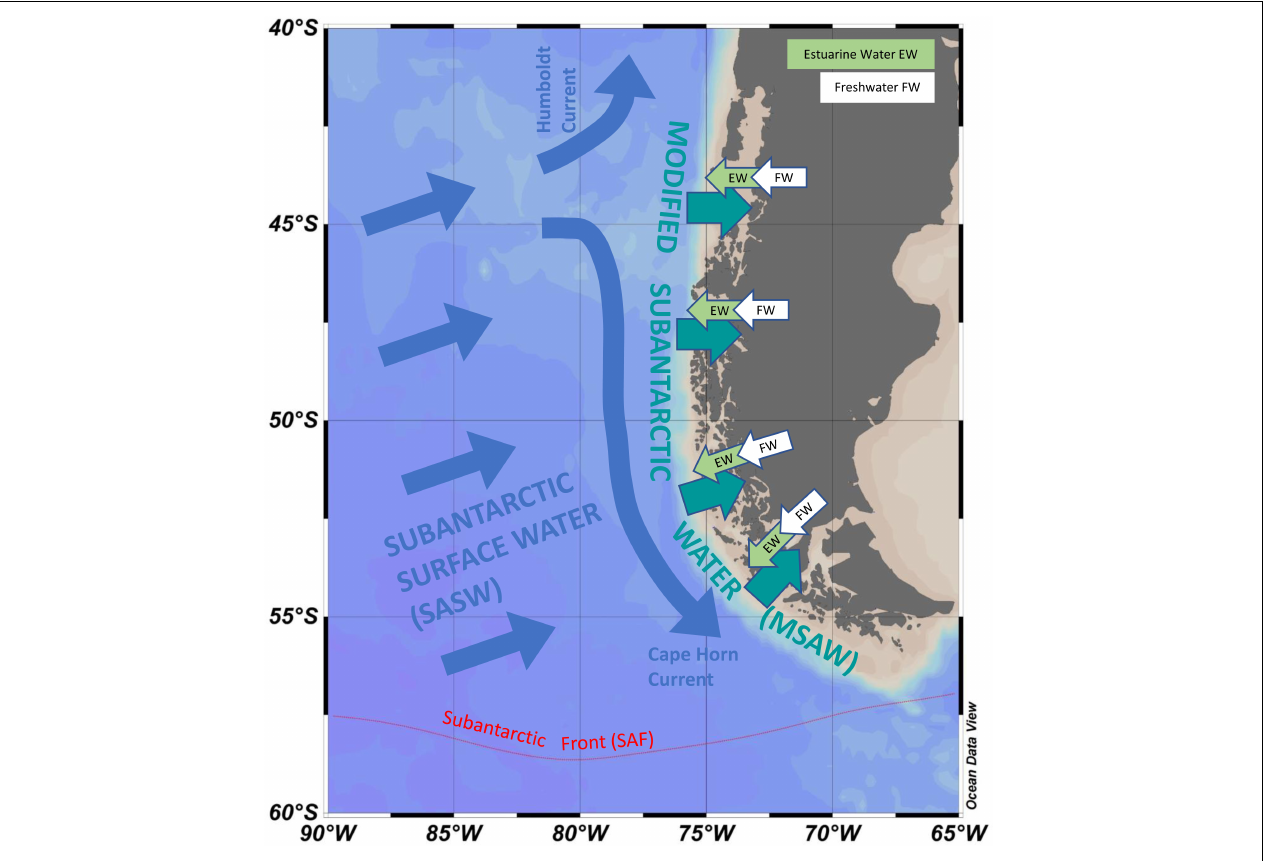
FIGURE 3 | Approximate schematic representation of how the southern Pacific Ocean influences fjords and channels of Patagonia and Tierra del Fuego. Subantarctic surface water (SASW) approaches the coast and interacts with continental run-off to form modified subantarctic water (MSAW) along the coast. MSAW enters the fjords and channels under a surface layer of estuarine water (EW) formed from freshwater flow (FW) derived from rainfall, rivers and glacial melt. Red dotted line gives approximate position of the Subantarctic Front (SAF). Position of currents and water masses are not drawn to